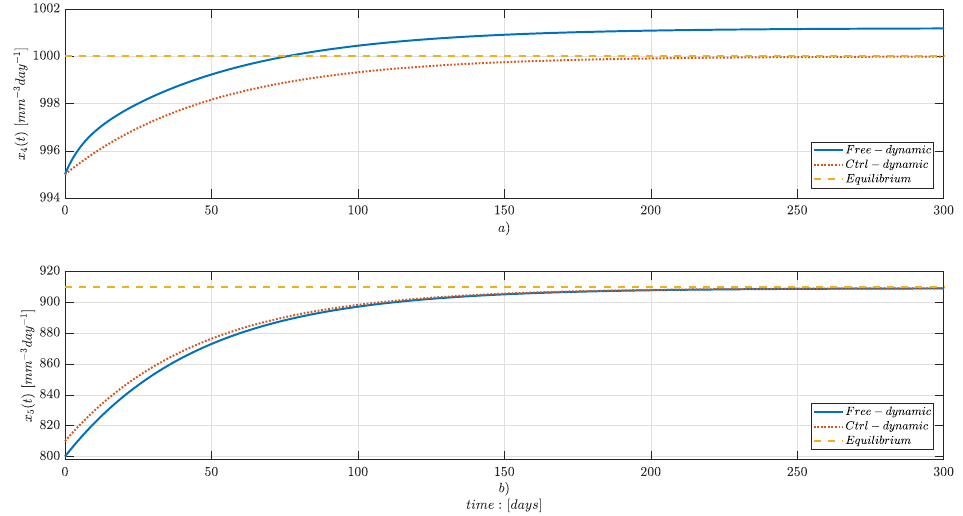
Figure 4. Convergence of the cell populations of T-cells and β -cells to their equilibrium state. ( a ) x 4 to x ∗ . ( b ) x 5 to x ∗ 5 4